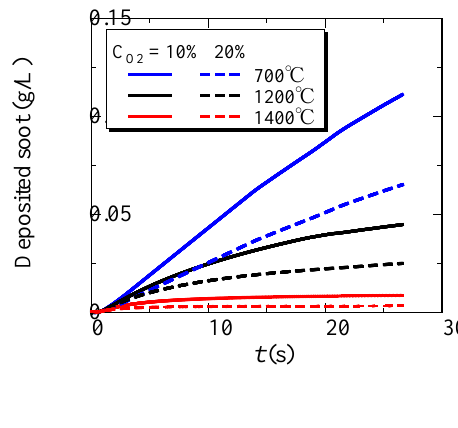
Figure 11. Time variations of the deposited soot amount inside the filter; T = 10%, 1400 °C and C O2